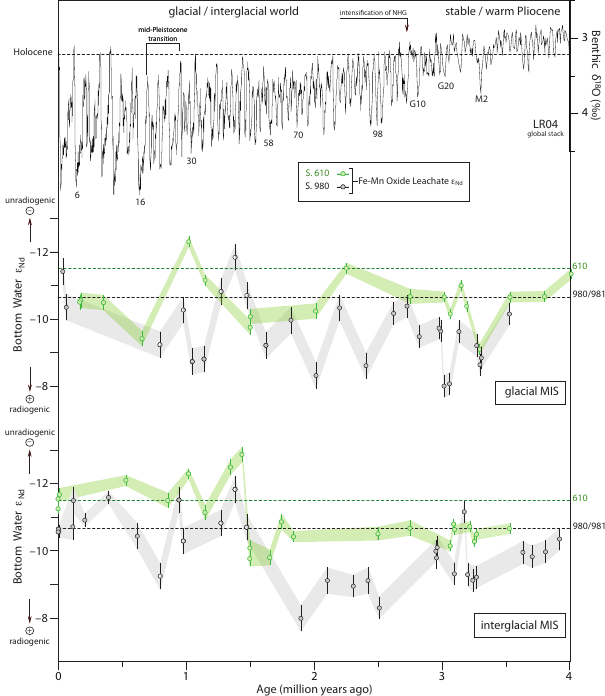
Figure 4. Comparison between changes in bottom-water ε Nd sig- natures at site 980/981 (grey dots; 2170m water depth) and site 610 (green dots; 2420m w.d.) during the studied glacial and inter- glacial marine isotope stages (MIS) as reflected in the global ben- thic foraminiferal δ 18 O stack LR04 of Lisiecki and Raymo (2005) for the last 4 million years. At site 980/981 samples reflecting the transition from glacial to interglacial condition are shown in dots colored half grey. Error bars and colored areas mark the 2 σ un- certainties of the measurements. Horizontal dashed lines mark sug- gested modern bottom-water ε Nd signature at study